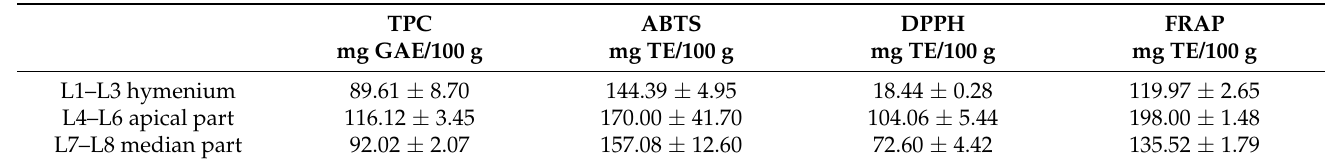
Table 4. Values of total phenolic content and antioxidant activity (ABTS, DPPH, and FRAP) of the extracts (mean values ± SD, n = 3).